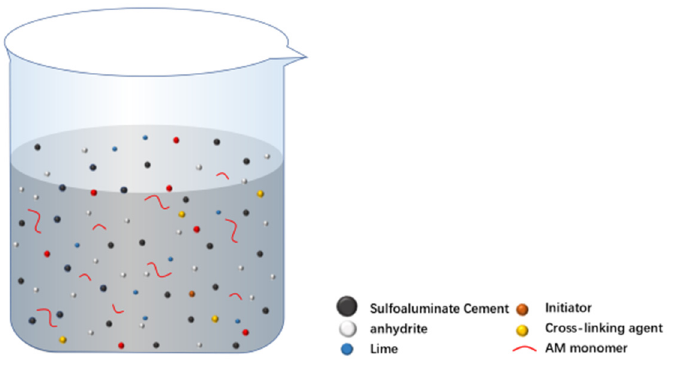
Figure 18. Schematic diagram of AM in situ polymerization of modified sulfoaluminate paste.